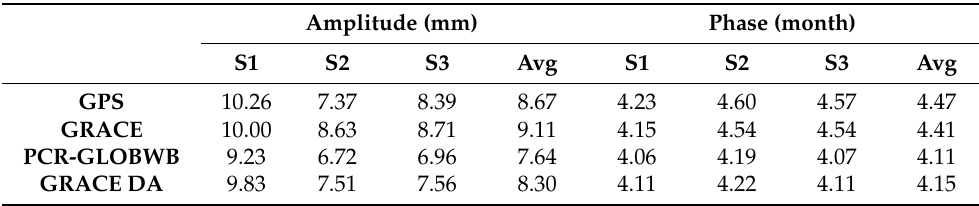
Table 3. The annual amplitude and phase estimates from the GPS, GRACE, PCR-GLOBWB, and GRACE DA-derived ∆ r at three evaluated sites (S1–S3). The average amplitude and phase values are also given in the right column (Avg).